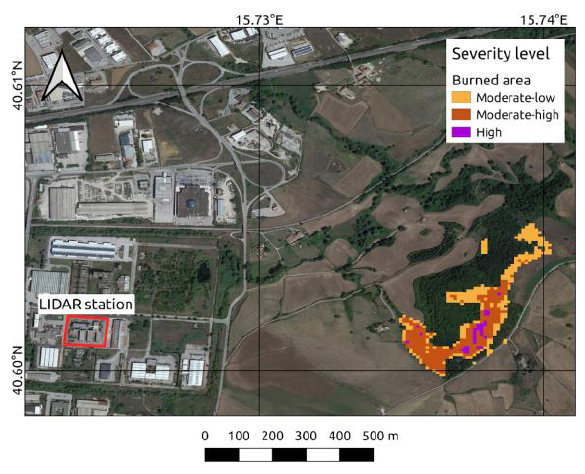
Figure 1. The fire severity map, estimated with MSI/Sentinel-2 data, indicates that the burnt oak forest fire occurred on 14 August 2021 near the ACTRIS/EARLINET station (red box).